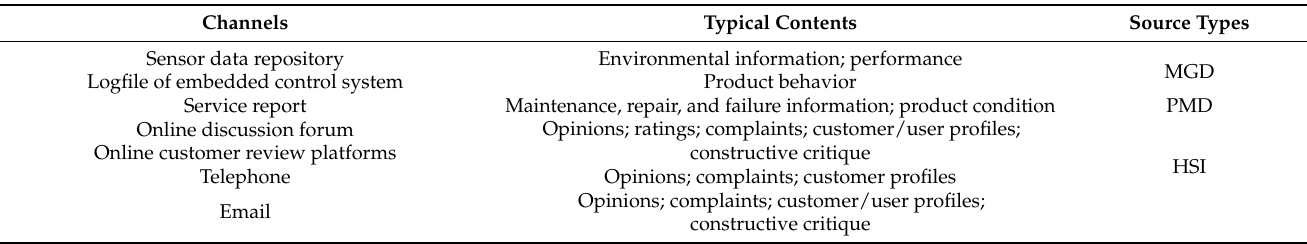
Table 1. PUI channels usable in product development.